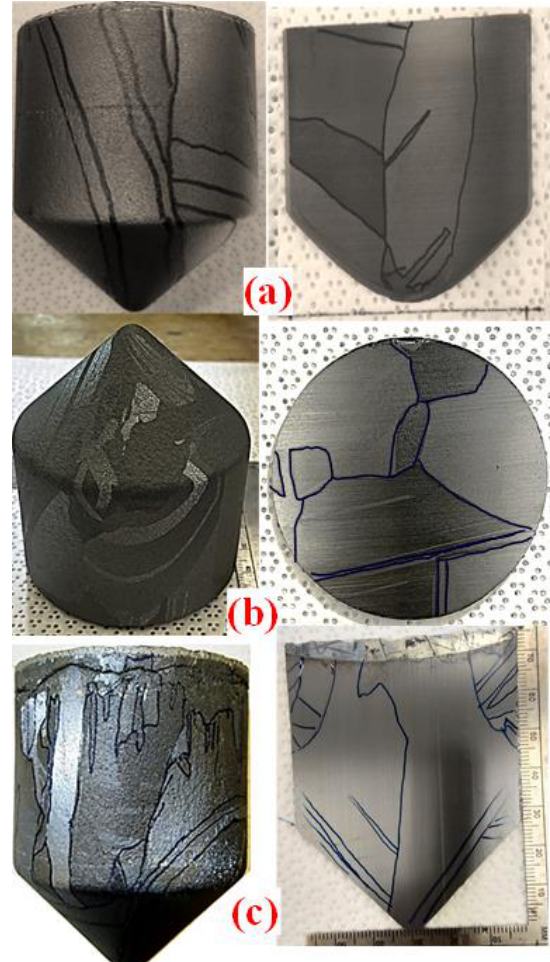
Figure 1. Pictures for ingots and marked wafers from ( a ) CRY-1, ( b ) CRY-2, and ( c ) CRY-3